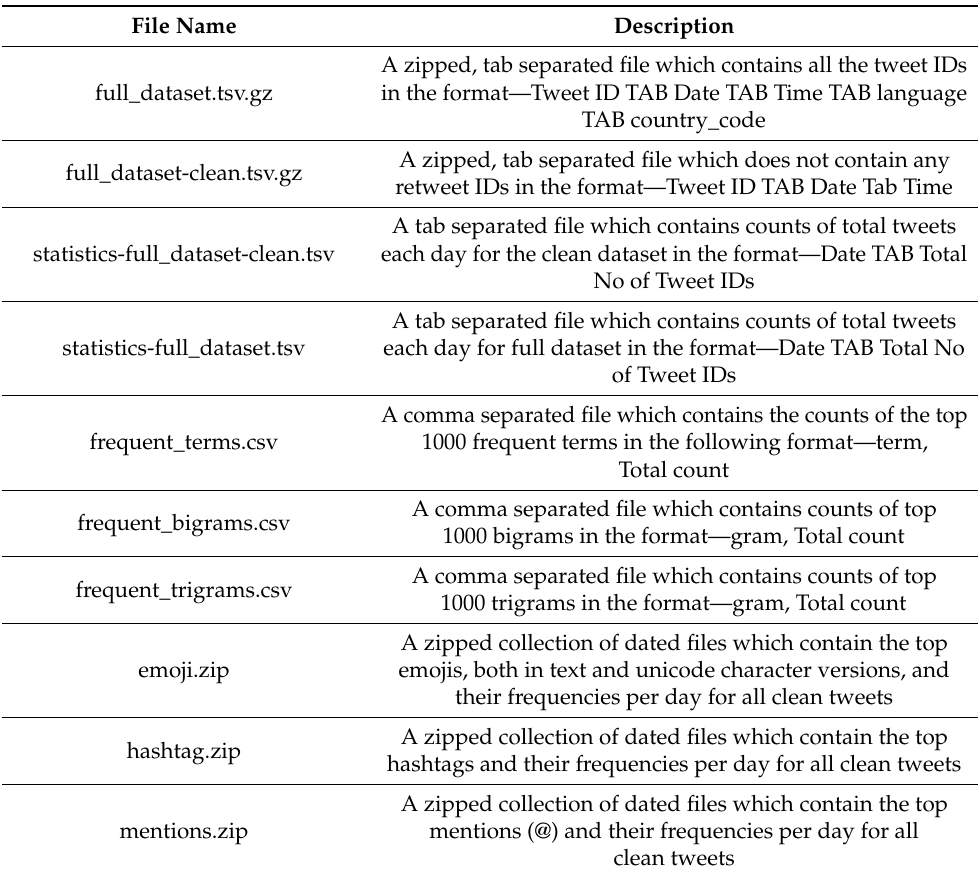
Table 2. Details of the released COVID-19 dataset. Note that the word TAB is not found, but